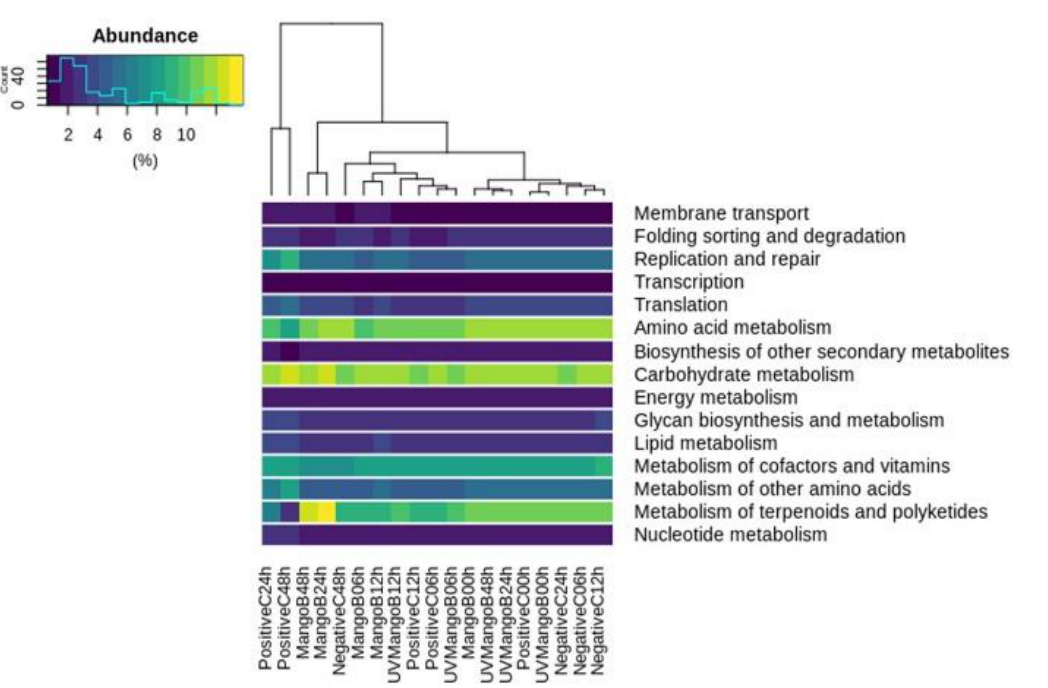
Figure 4. Heatmap of bacterial-predicted metabolic functionality based on phylogenetic investigation of communities by reconstruction of unobserved state (PICRUSt) analysis and Kyoto Encyclopedia of Genes and Genomes (KEGG). The rows indicate the KEGG level-2 pathway ( > 1% of abundance) and the columns show the hierarchical clusters of the negative control (NegativeC), positive control (PositiveC), UV-C irradiated mango bar (UVMangoB) and non-irradiated mango bar (MangoB) samples.